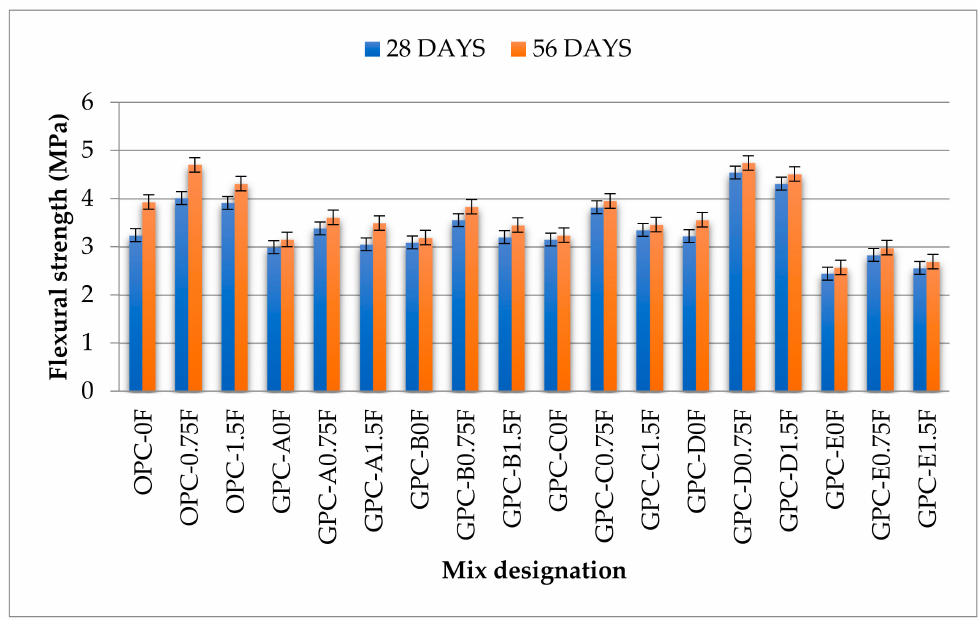
Figure 10. The flexural strength values of GPC and OPC